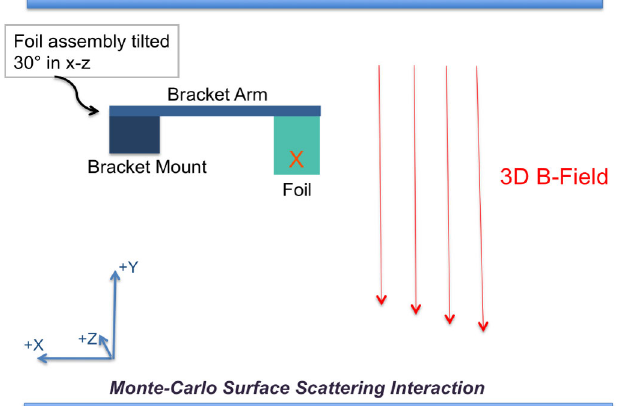
FIG. 8. Cartoon representation of the simulation configuration showing the foil assembly, the apertures, the B field primary ), and the coordinate system. Note that surface component ( B y scattering occurs only on an electron’s first interaction with the (cid:1) y